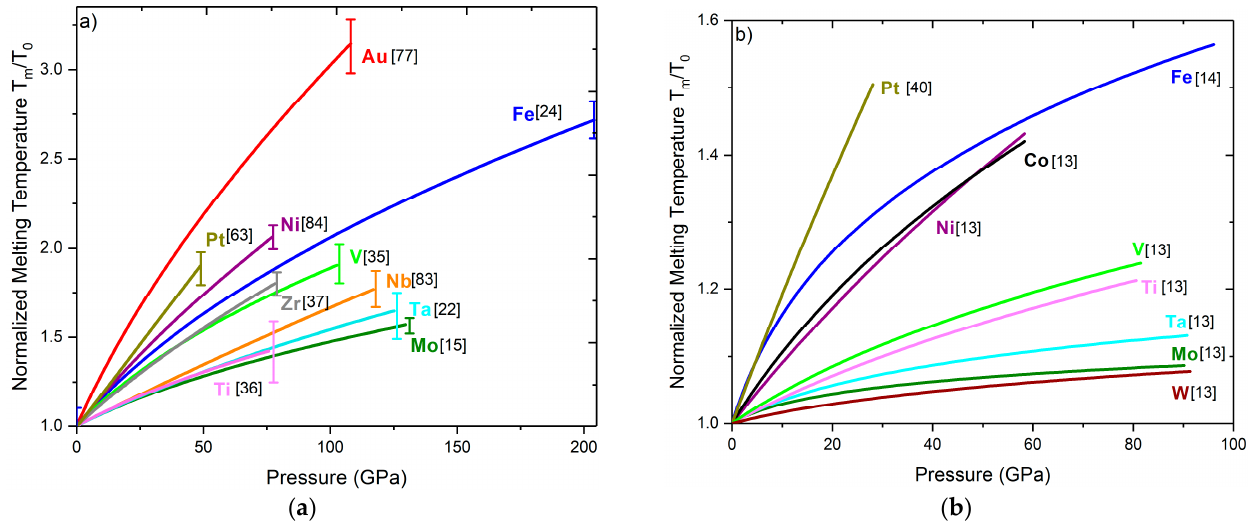
Figure 1. Normalized melting temperatures T m /T 0 for several d ‐ transition metals. All the melting curves in each graph were obtained with the same method: ( a ) XRD diagnostic (Section 4.2), ( b ) Speckle diagnostic (Section 4.1). The error bars in Figure 1a refer to the reported uncertainties in temperature measurement by using the XRD diagnostic. Datasheets can be found in the Supplemental Material.